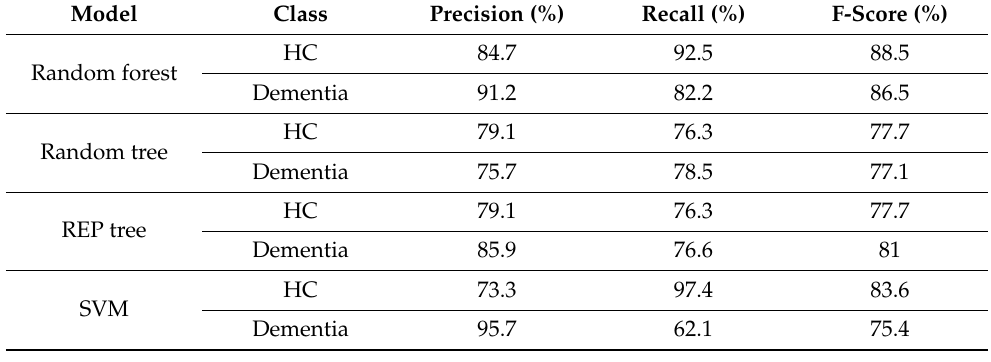
Table 2. Performance of machine-learning models.